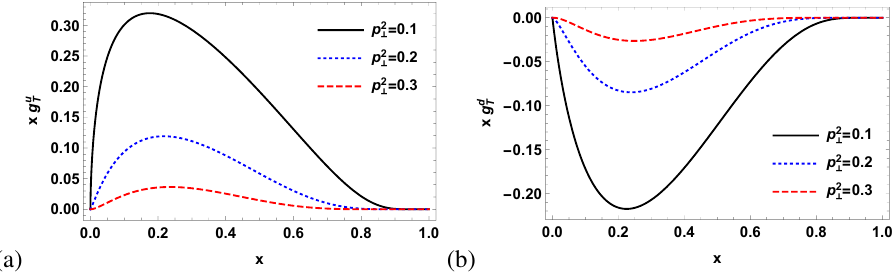
Figure 1: (Color online) The transversely polarized TMD x g ν to x at di ff erent values of p 2 respectively.